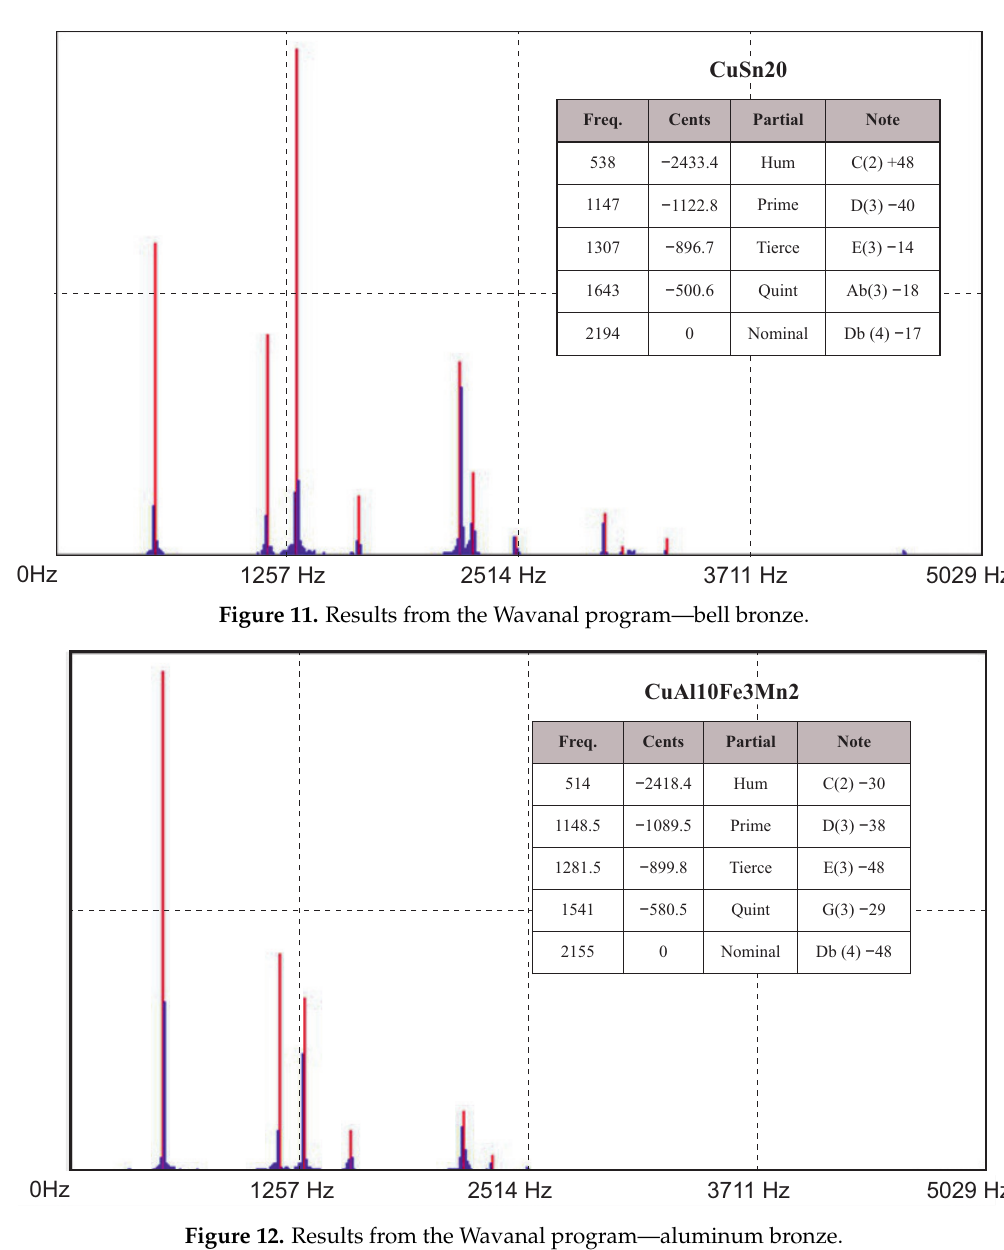
Figure 12. Results from the Wavanal program—aluminum